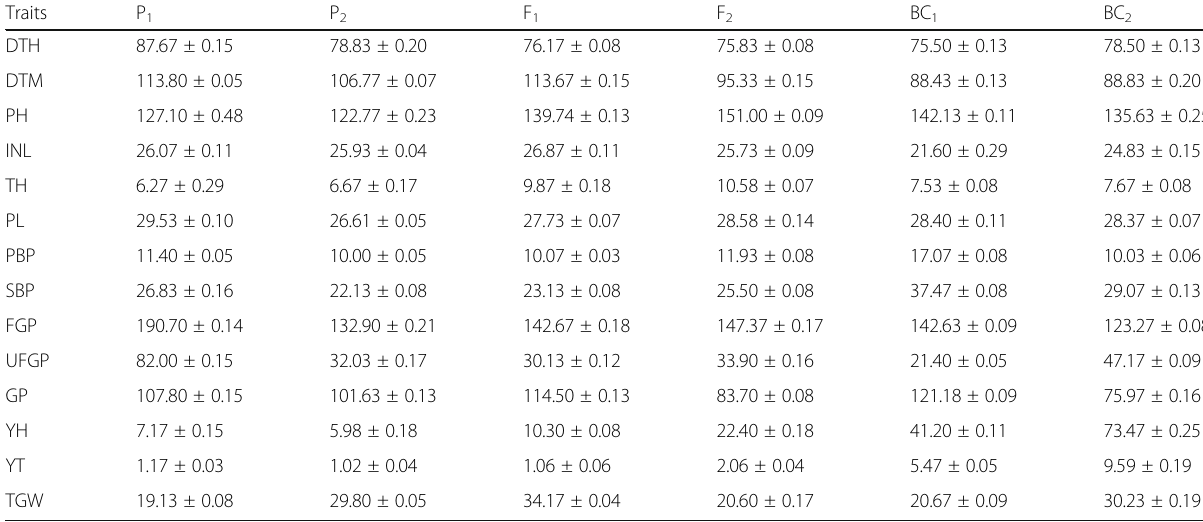
Table 1 Mean performance and standard error of yield-contributing traits in six populations of submergence rice Traits P 1 P 2